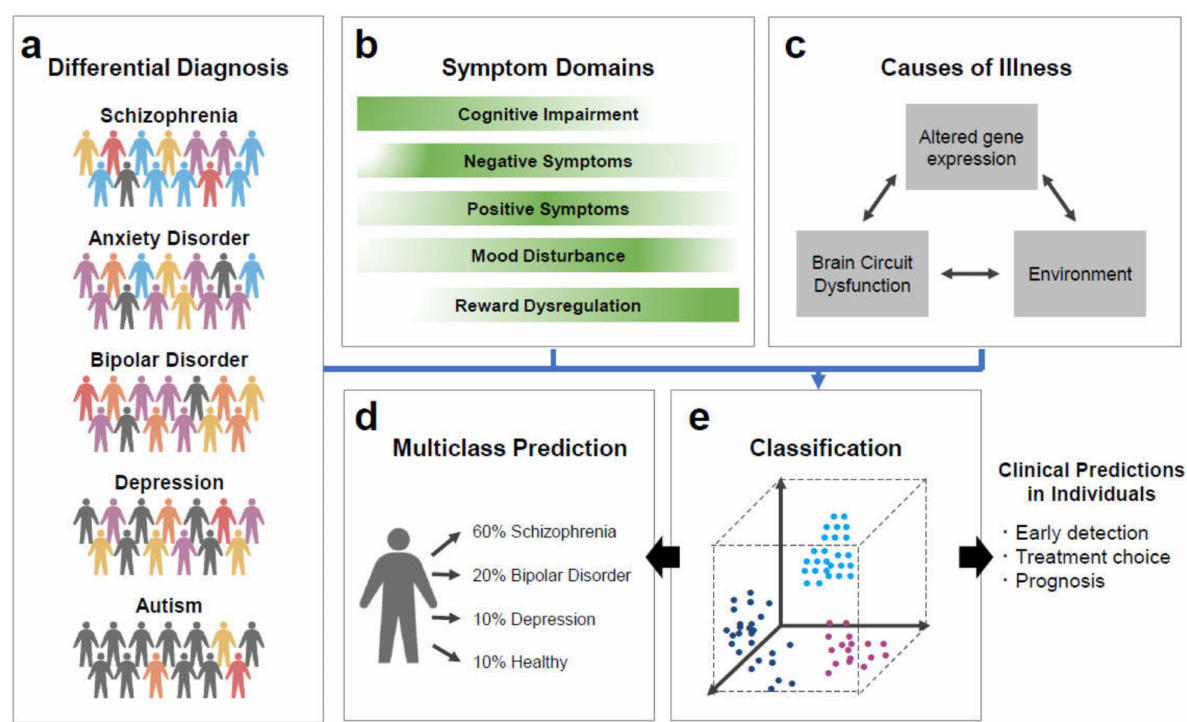
Figure 3. Challenges for precision medicine in psychiatry by artificial intelligence. ( a ) Traditional psychiatric research investigates a given patient group by comparison against the healthy group, possibly creating artificial dichotomies. ( b ) Each psychiatric disorder has various types of the symptoms with their varying degrees. ( c ) The interplay between altered gene expression and neural circuit, and environment such as stress, may elicit psychiatric manifestations. Instead of relying on diagnostic category, a given patient can be classified based on biological and pathological properties (i.e. endophenotypes). ( d ) Artificial intelligence such as machine learning can be extended to compare observations from numerous groups in the same statistical estimation. ( e ) Machine learning algorithms, such as SVM, can automatically extract unknown patterns of variations in individuals simultaneously from heterogenous data labeled with traditional diagnosis. Predictive models could improve patient care by early detection, treatment choice, and